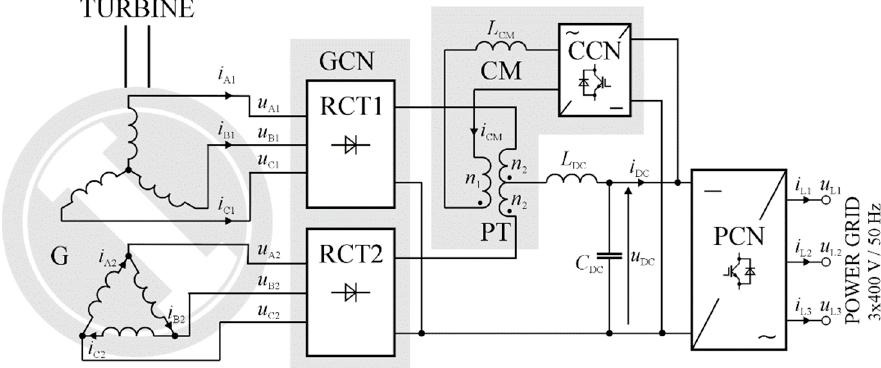
Figure 4. Block diagram of the proposed energy conversion system. PCN, power grid side converter; GCN, generator side converter.